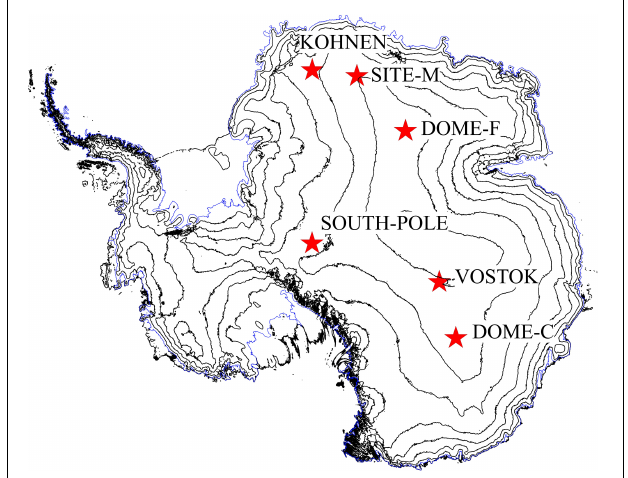
FIGURE 1 | Map of Antarctica including our study area and other ice-core drilling sites for comparison; elevation model according to Howat et al.